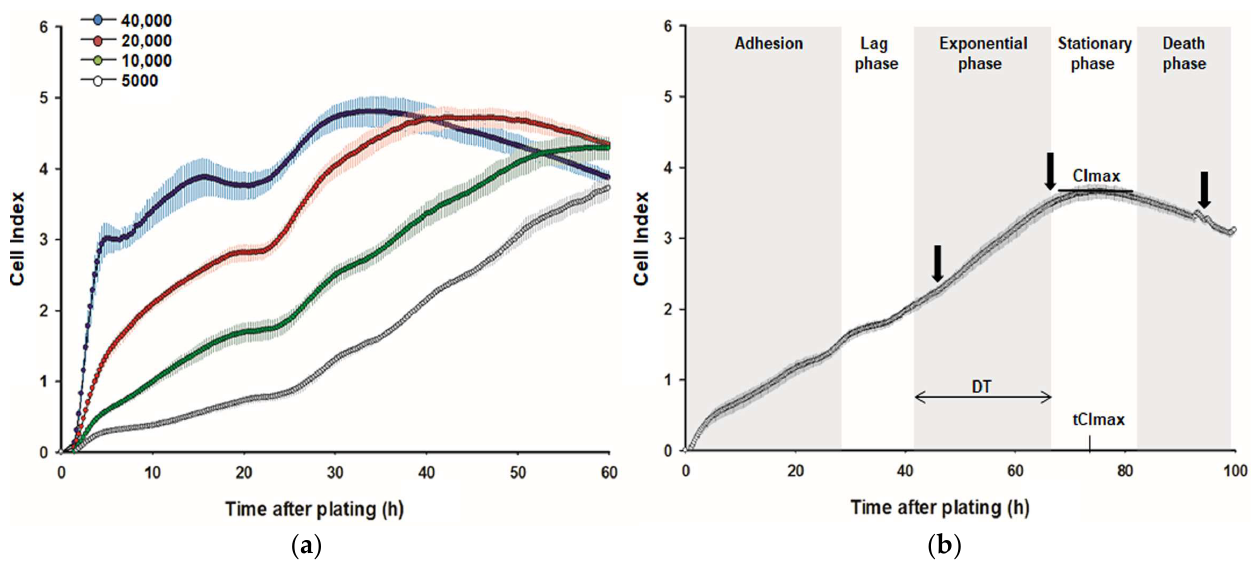
Figure 2. xCELLigence-system-based real-time monitoring of C2C12 cell growth kinetics. ( a ) C2C12 cells were seeded at densities of 5000, 10,000, 20,000, or 40,000 cells per well to select an appropriate cell number for proliferation assays. The results indicated that a cell density of 5000 per well could be chosen as a standard. Representative growth curves are shown. ( b ) Representative original kinetic growth curve and characteristic growth phases for C2C12 cells seeded at a density of 5000 per well. During the exponential phase, the doubling time (DT) was calculated. At the end of the exponential phase (transition to stationary phase), the maximum Cell Index (CImax) and the time to achieve the CImax (tCImax) were determined. The black arrows symbolize the time points for the determination of DNA and protein amount, as well as viability and metabolic activity